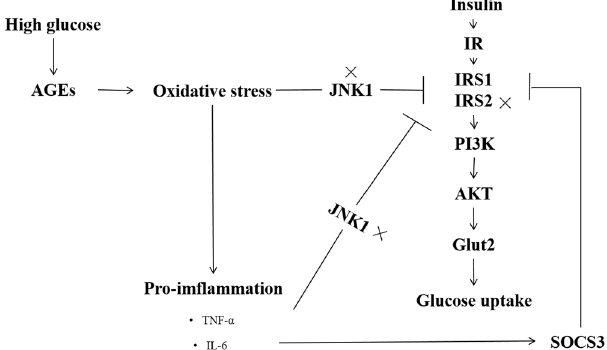
Figure 5. A potential reason of high gluose intolerance in Japanese flounder.